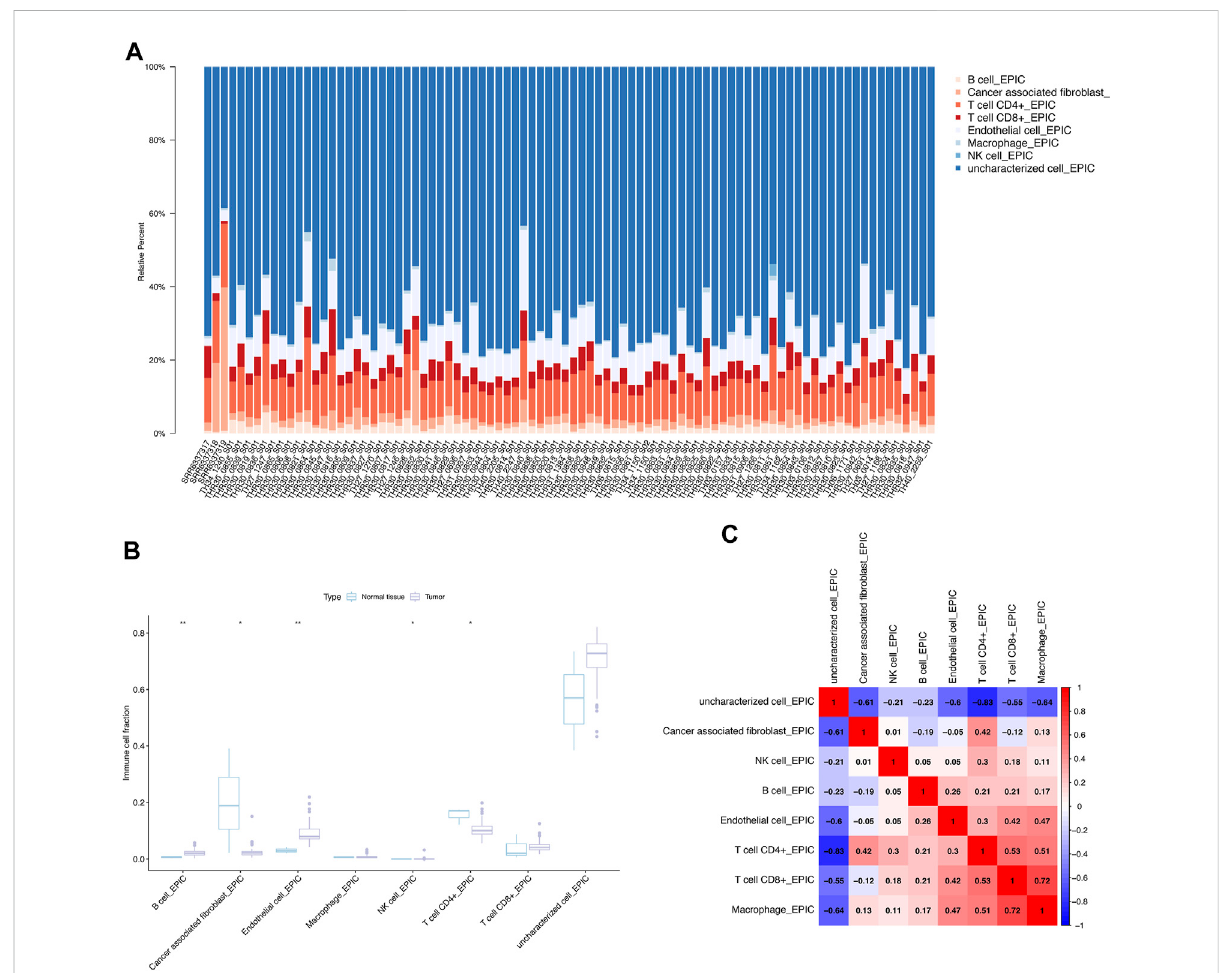
FIGURE 3 CIBERSORT analysis and co-expression analysis. (A) The proportions of 8 immune cells in 85 Ewing sarcoma patients and 3 normal samples explored by CIBERSORT analysis. (B) The immunein fi ltration of Ewing sarcomaand normal bone tissues. (C) The co-expression patternsof immune cells in Ewing